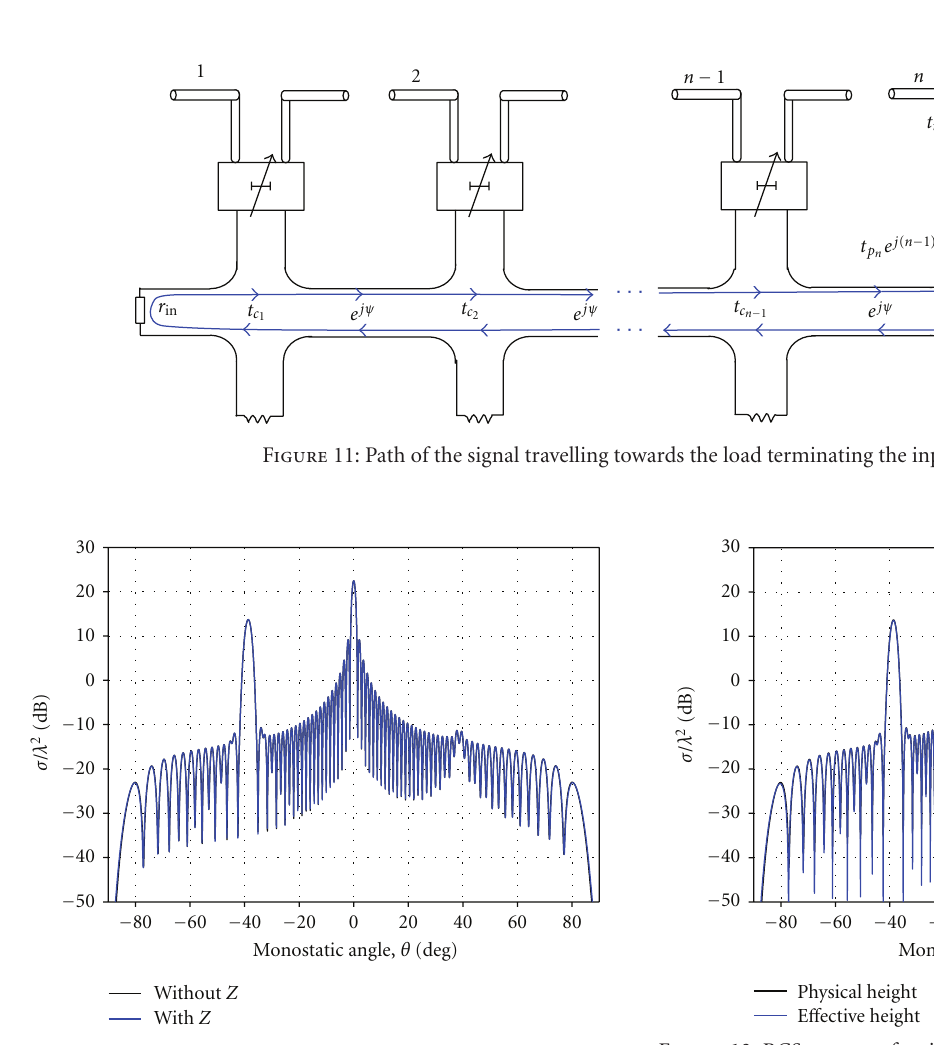
Figure 12: RCS pattern of a 50-element series-fed phased array. ψ = π/ 2, d = 0 . 4 λ , l = 0 . 5 λ , and r θ s = 0 ◦ , uniform unit amplitude distribution.